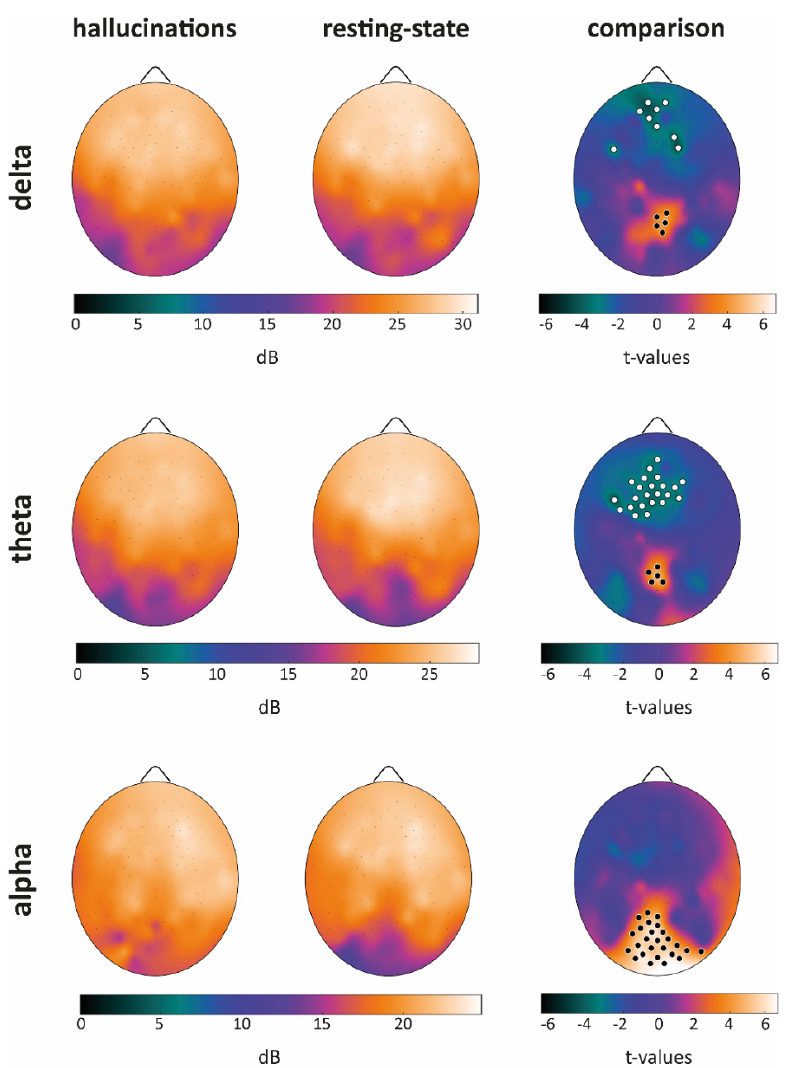
Figure 1. Average scalp maps for each band and condition are presented in the first two columns. Band-wise comparisons are presented in the third column. Black dots indicate electrodes showing a significantly higher PSD during the VH condition as compared to RS, white dots the opposite relationship. Critical t-values (in absolute value) for significance at p = 0.05 are, respectively, |t| = 3.22 for delta, |t| = 3.13 for theta and |t| = 3.12 for alpha band (single-threshold tests for the maximum t-statistics).